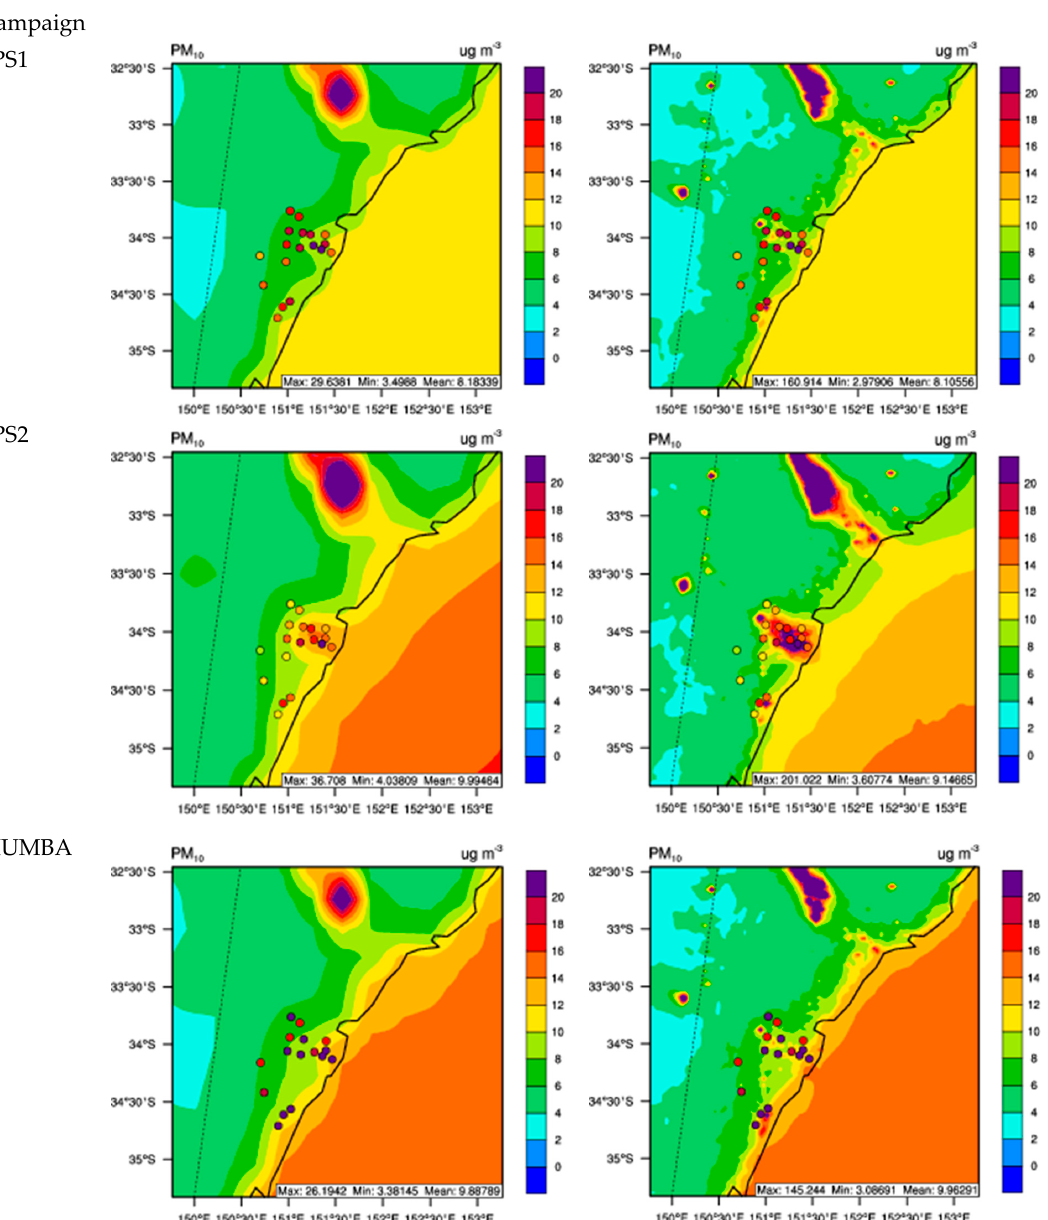
Figure 9. Simulated spatial distribution of surface concentrations of PM 10 overlaid with observations over the Greater Sydney area (d04). All simulation results are based on WRF/Chem-ROMS.